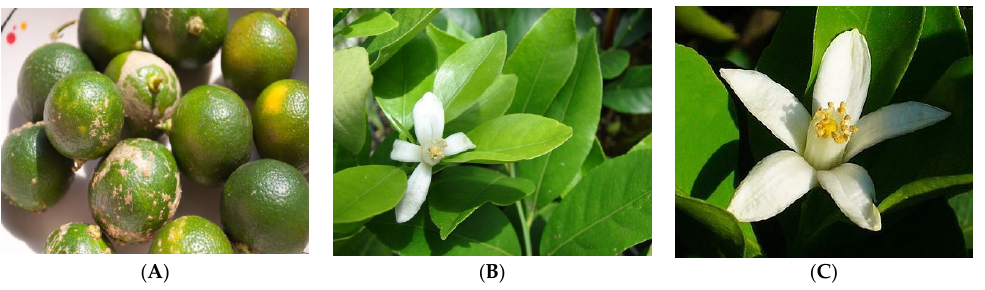
Figure 5. The ( A ) fruit; ( B ) leaf and ( C ) flower of C. microcarpa. (Photos kredit: Ronald Escanlar, Forest Starr and Kim Starr, H. Zell)